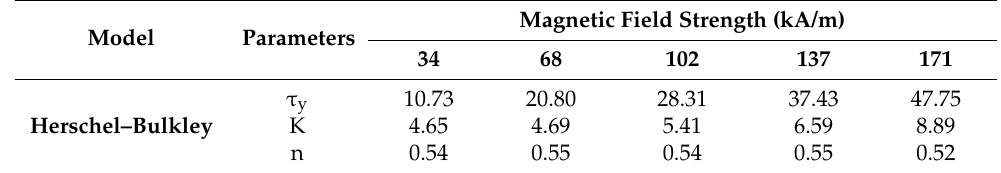
Table 2. Parameter of H-B equation fitting deduced from ZnFe 2 O 4 /PMA-based MR fluid.